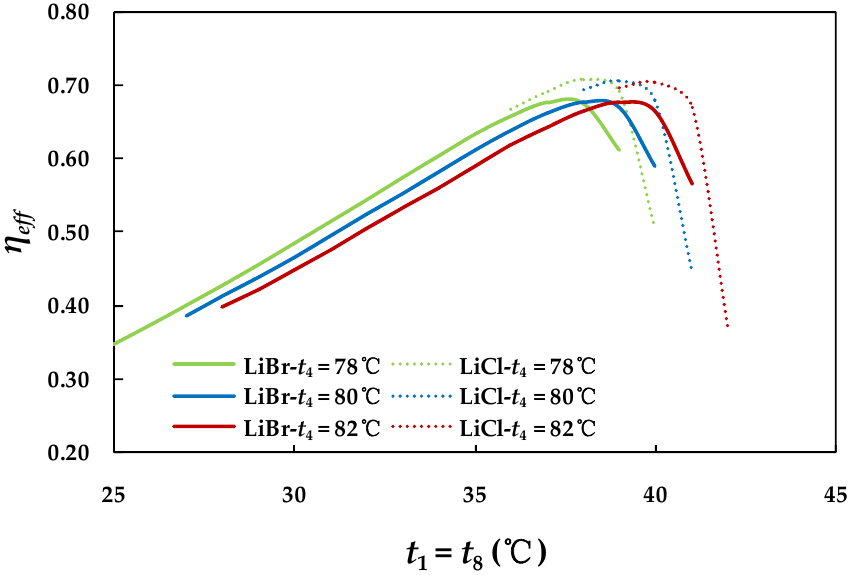
Figure 6. Condenser and absorber temperatures impact on the efficiency ratio of the absorption system under various generator temperature levels (78 °C, 80 °C, and 82 °C) for the two working pairs ( t 10 = 7 °C, ε = 0.7).